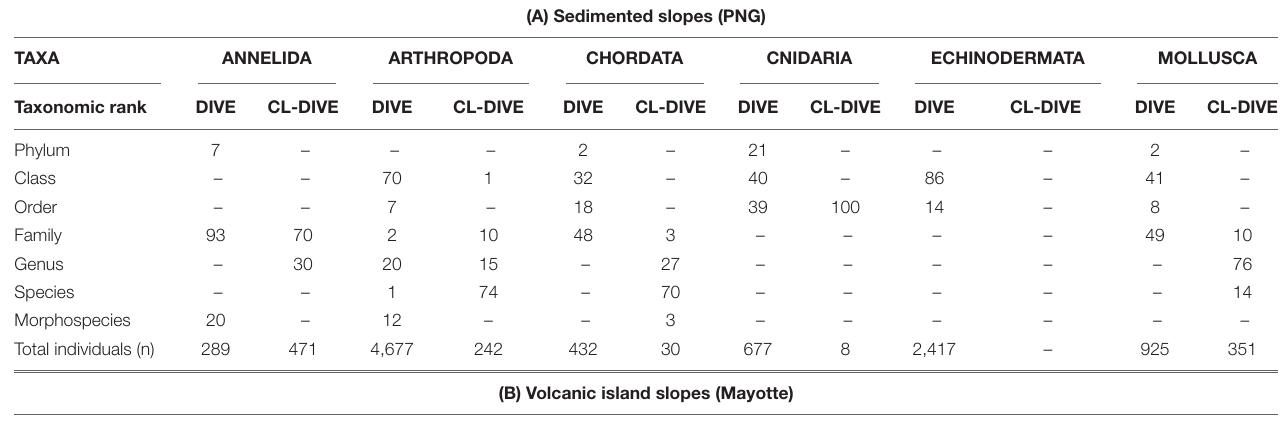
TABLE 3 | Percentages of individuals identified by taxonomic rank and by method (images = dive, sampling along dive = cl-dive), (A) along sedimented slopes (PNG) and (B) along volcanic island slopes dominated by hard bottom (Mayotte) with (C) a focus on echinoids and asteroids.